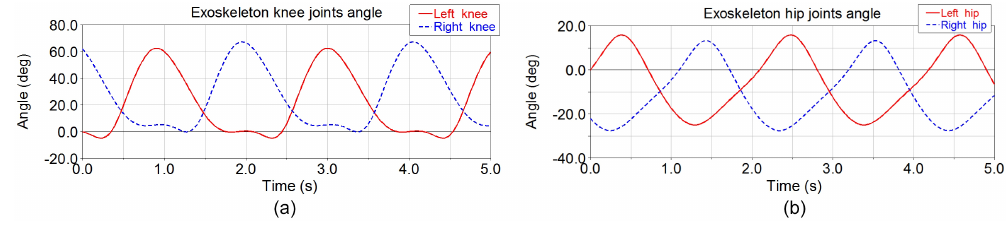
Figure 17. Computed exoskeleton joints angle (dotted line-right leg, continuous line-left leg): (a) knee joints; (b) hip joints.